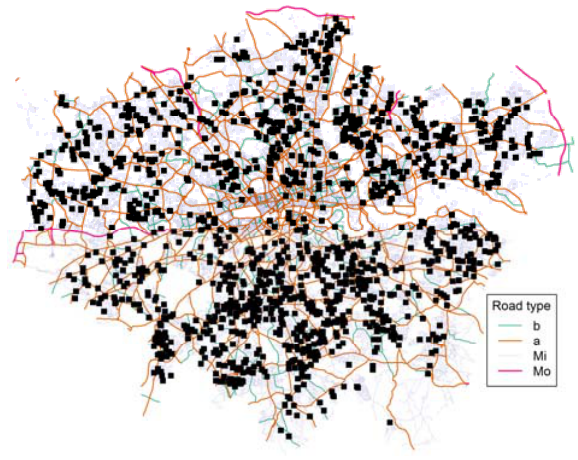
Figure 3. Case study data sets: London house price and road network data.